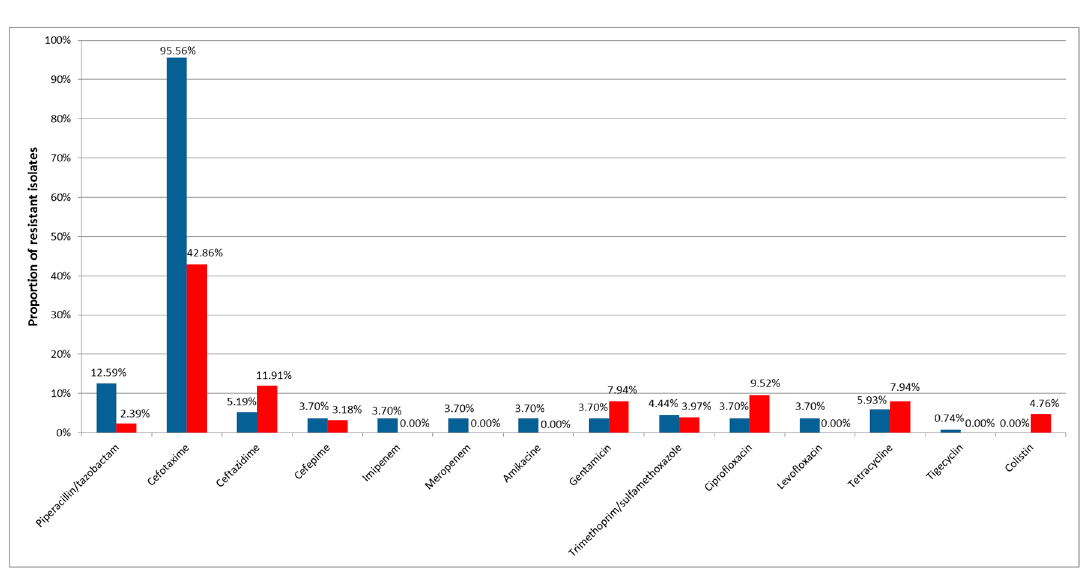
Figure 1. Percentage of resistance to tested antibiotics of isolated Acinetobacter baumannii (blue) and non -baumannii Acinetobacter spp. (red).